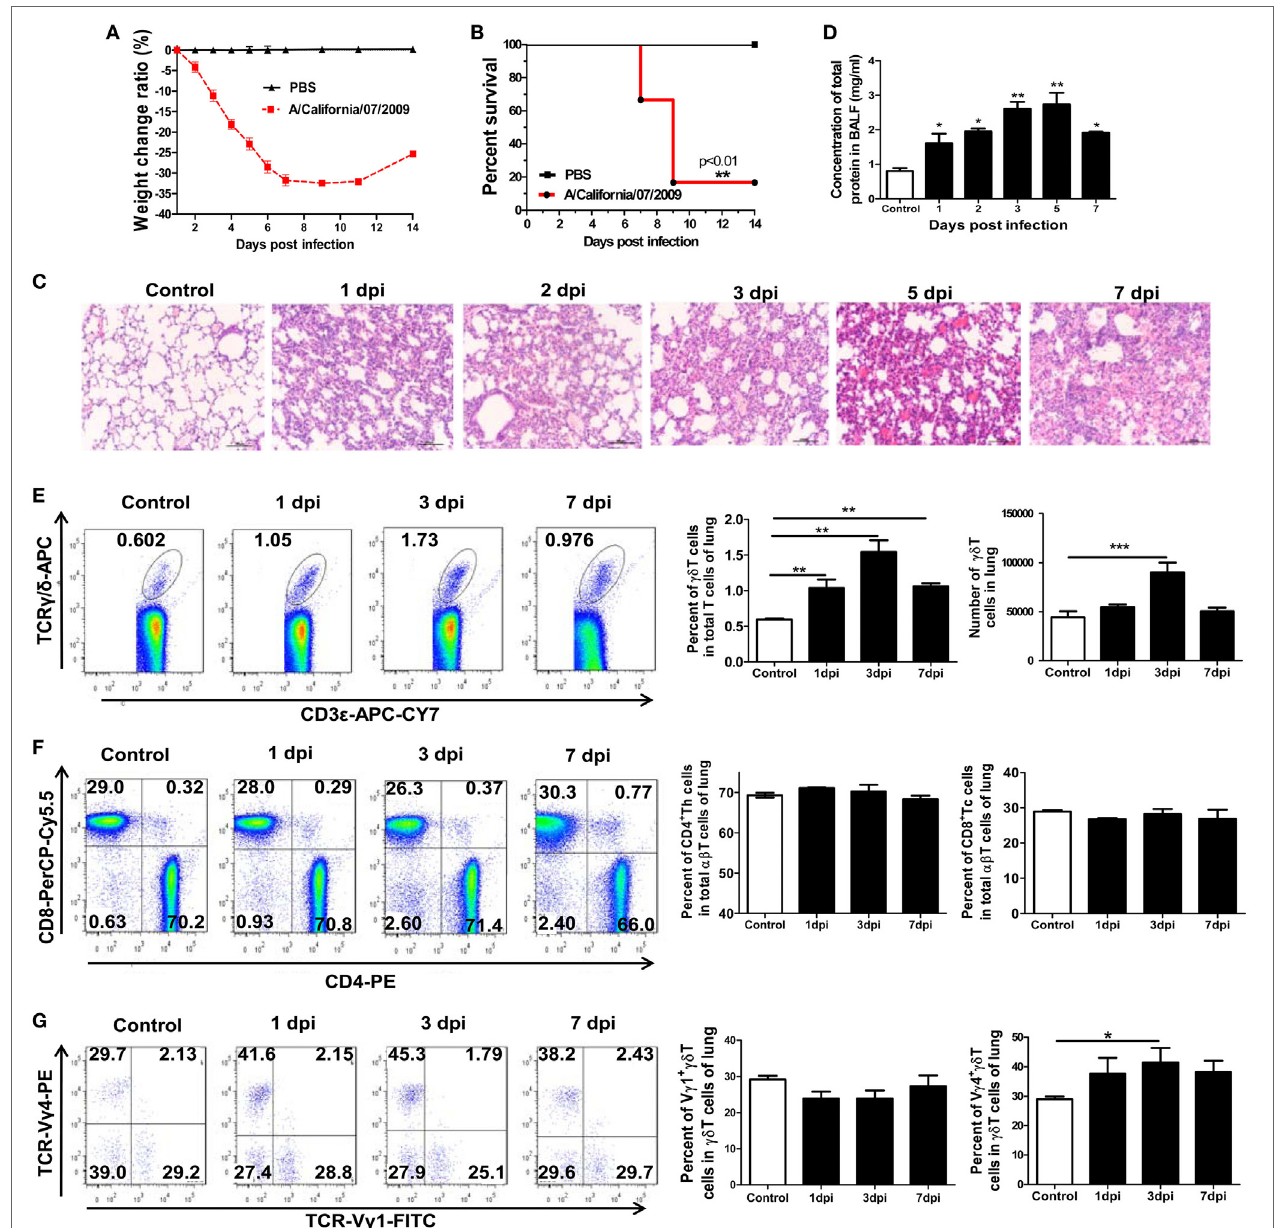
FigUre 1 | Establishment of a mouse model of severe influenza A (H1N1) pdm09 infection and the changes in T-cell subsets in the lungs after infection. Weight change ratio (a) and survival rate (B) of infected mice ( n = 6) and uninfected control mice ( n = 6) observed over 14 days. (c) Immunopathological damage detected by hematoxylin and eosin staining of the lungs of infected mice at the indicated dpi. Original magnification: × 200. (D) Changes in total protein concentration in bronchoalveolar lavage fluid (BALF) of infected mice assayed at the indicated dpi. (e) Percentage and number of CD3 + TCR γδ + T cells in the lungs detected using flow cytometry for the control, 1, 3, and 7 dpi groups. (F) Percentage of CD3 + TCR αβ + CD4 + Th and CD3 + TCR αβ + CD8 + Tc cells in the lungs was analyzed using flow cytometry for the control, 1, 3, and 7 dpi groups. The stained lung lymphocytes were first gated on CD3 + TCR αβ + , and then, the CD4 + Th and CD8 + Tc subsets were analyzed. (g) Percentage of V γ 1 + γδ T and V γ 4 + γδ T cells in the lungs of infected mice at the indicated dpi. The stained lung lymphocytes were first gated on CD3 +